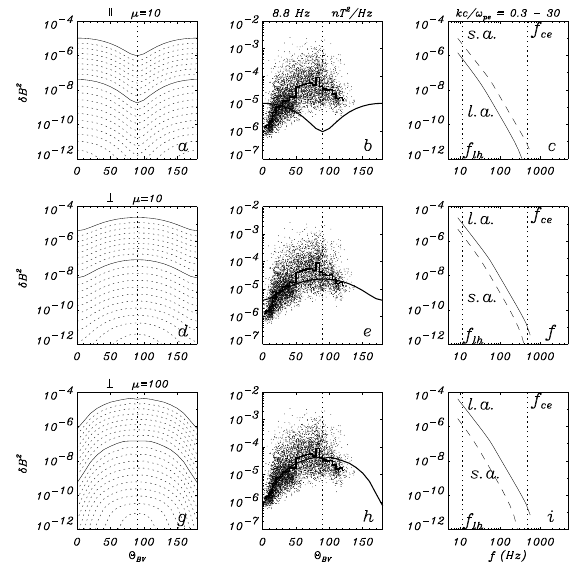
2 ( f, Θ BV ) Figure6:Themodel δB (Eq.4)withapureDopplershiftandnodisper- k ) sionrelationinEq.1.Thedistribution I 3 D ( isgivenbyEq.5with ν =3to4,for kc/ω pe ≃ 0.3to30,andfortheaverageparametersoftheday19/12/2001.Forwave B k ) Fig. 6. The model δB 2 (f,2 BV ) (Eq. 4) with a pure Doppler shift (Eq.6)andfor µ =10(largeangularwidthof I 3 D ( ): ve torsmostlyparallelto 2 (Θ BV ) a)themodel δB attheSTAFF-SAfrequen ies,from8.8Hz(uppersolid and no dispersion relation in Eq. (1). The distribution I 3 D ( k ) is line)to561Hz(lowerdottedline);arbitraryordinates.b)themodelat8.8Hz (solidline) omparedtothes atterplotandthemedianoftheobservationsatthe given by Eq. (5) with ν =3 to 4, for kc/ω pe ’ 0.3 to 30, and for samefrequen y,asafun tionof Θ BV ; )themodelspe traforlarge Θ BV angles (solidline, l.a. )andforsmall Θ BV angles(dashedline, s.a. ).Theverti aldotted the average parameters of 19 December 2001. For wave vectors linesgivetheaveragevaluesof f lh and f ce onthe19/12/2001.Forwaveve tors B k ) mostlyperpendi ularto (Eq.7)andfor µ =10(largeangularwidthof I 3 D ( ): mostly parallel to B (Eq. 6) and for µ =10 (large angular width of 2 (Θ BV ) d)themodel δB atdi(cid:27)erentfrequen ies,e)themodel(solidline)andthe I 3 D ( k ) ): (a) the model δB 2 (2 BV ) at the STAFF-SA frequencies, data,stillat8.8Hz;f)themodelspe tra.WithEq.7andfor µ =100(stronger 2 (Θ BV ) k ) anisotropyof I 3 D ( ):g)themodel δB atdi(cid:27)erentfrequen ies;h)agood from 8.8Hz (upper solid line) to 561Hz (lower dotted line); arbi- agreementbetweenthemodel(solidline)andthedata;i)themodelspe tra. trary ordinates. (b) the model at 8.8Hz (solid line) compared to 6 the scatter plot and the median of the observations at the same fre- quency, as a function of 2 BV ; (c) the model spectra for large 2 BV angles (solid line, l.a.) and for small 2 BV angles (dashed line, s.a.). The vertical dotted lines give the average values of f lh and f ce on 19 December 2001. For wave vectors mostly perpendicular to B (Eq. 7) and for µ =10 (large angular width of I 3 D ( k ) ): (d) the model δB 2 (2 BV ) at different frequencies, (e) the model (solid line) and the data, still at 8.8Hz; (f) the model spectra. With Eq. (7) and for µ =100 (stronger anisotropy of I 3 D ( k ) ): (g) the model δB 2 (2 BV ) at different frequencies; (h) a good agreement between the model (solid line) and the data; (i) the model